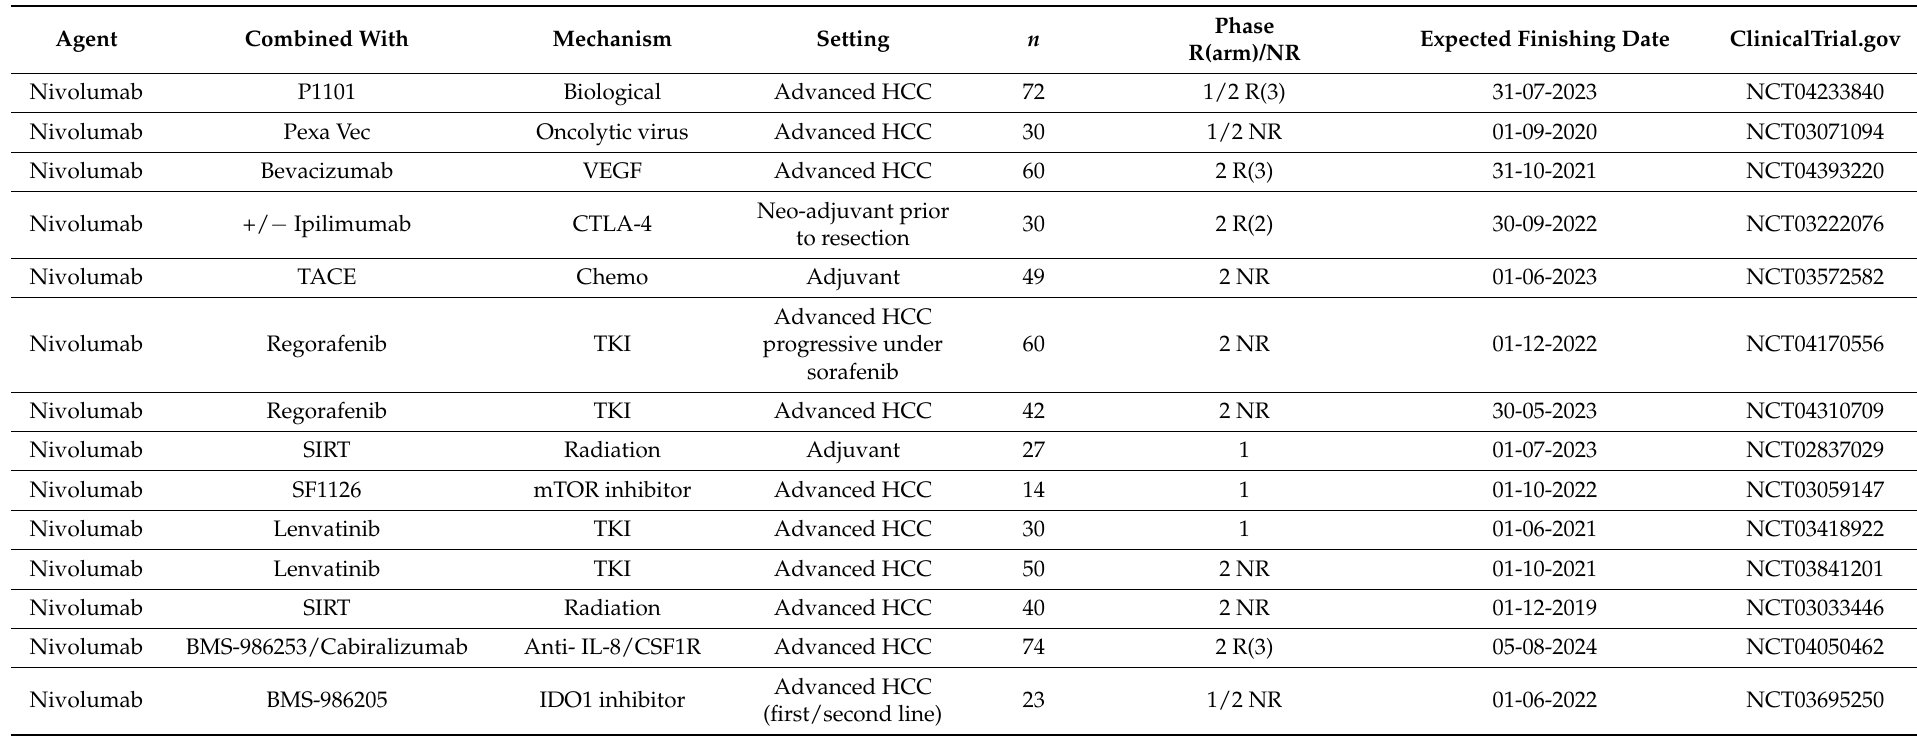
Table 3. Ongoing/coming trials with immune checkpoint inhibitors in the treatment of HCC (as per